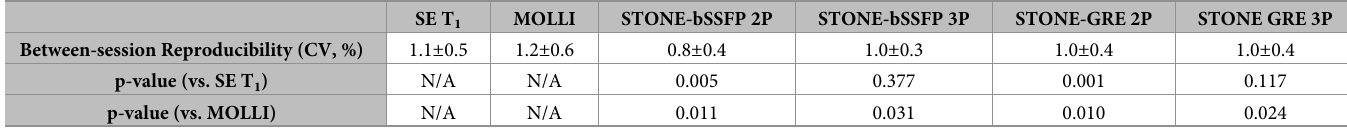
Table 2. Between-session reproducibility and the comparison of slice-interleaved T 1 mapping sequences against SE T 1 and MOLLI.